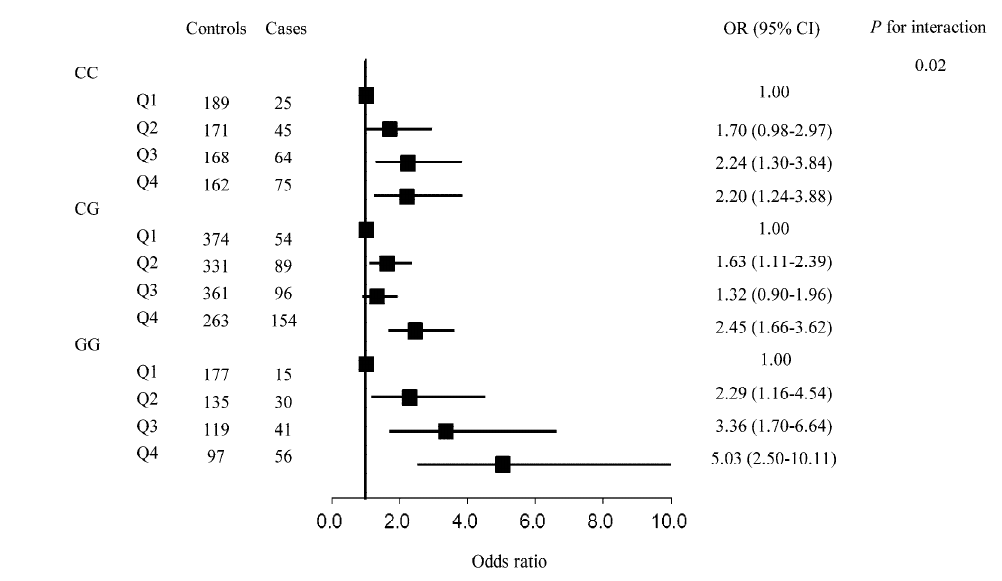
Figure 1. The association between carotid intima-media thickness (in quartiles) and ischemic stroke stratified by rs2910164 genotype. Results were adjusted for age (continuous), sex (male, female), educational levels (less than primary school, primary school, middle school, high school, college and above, missing), body mass index (continuous), alcohol consump- tion (current, former, never, missing), smoking status (current, former, never, missing), type 2 diabetes (yes/no), hyper- tension (yes/no), and coronary heart disease (yes, no, missing).